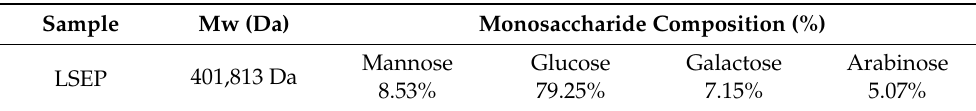
Table 1. The molecular weight and monosaccharide composition of